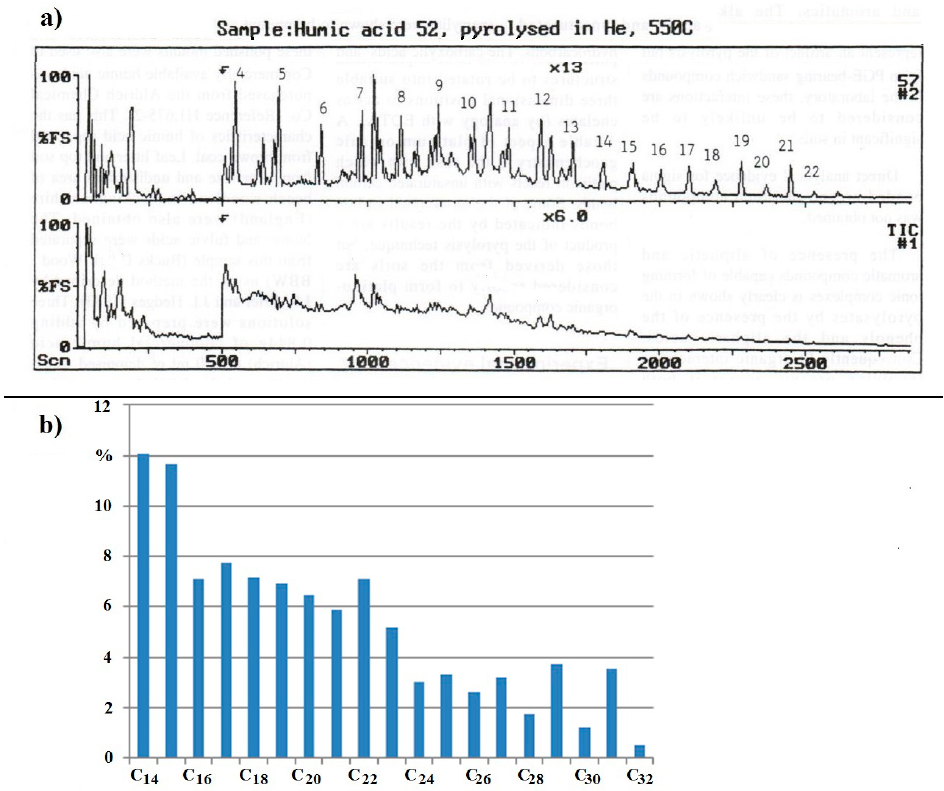
Figure 4. ( a ) Total ion current chromatogram (lower trace) and selected ion trace (upper trace) of a